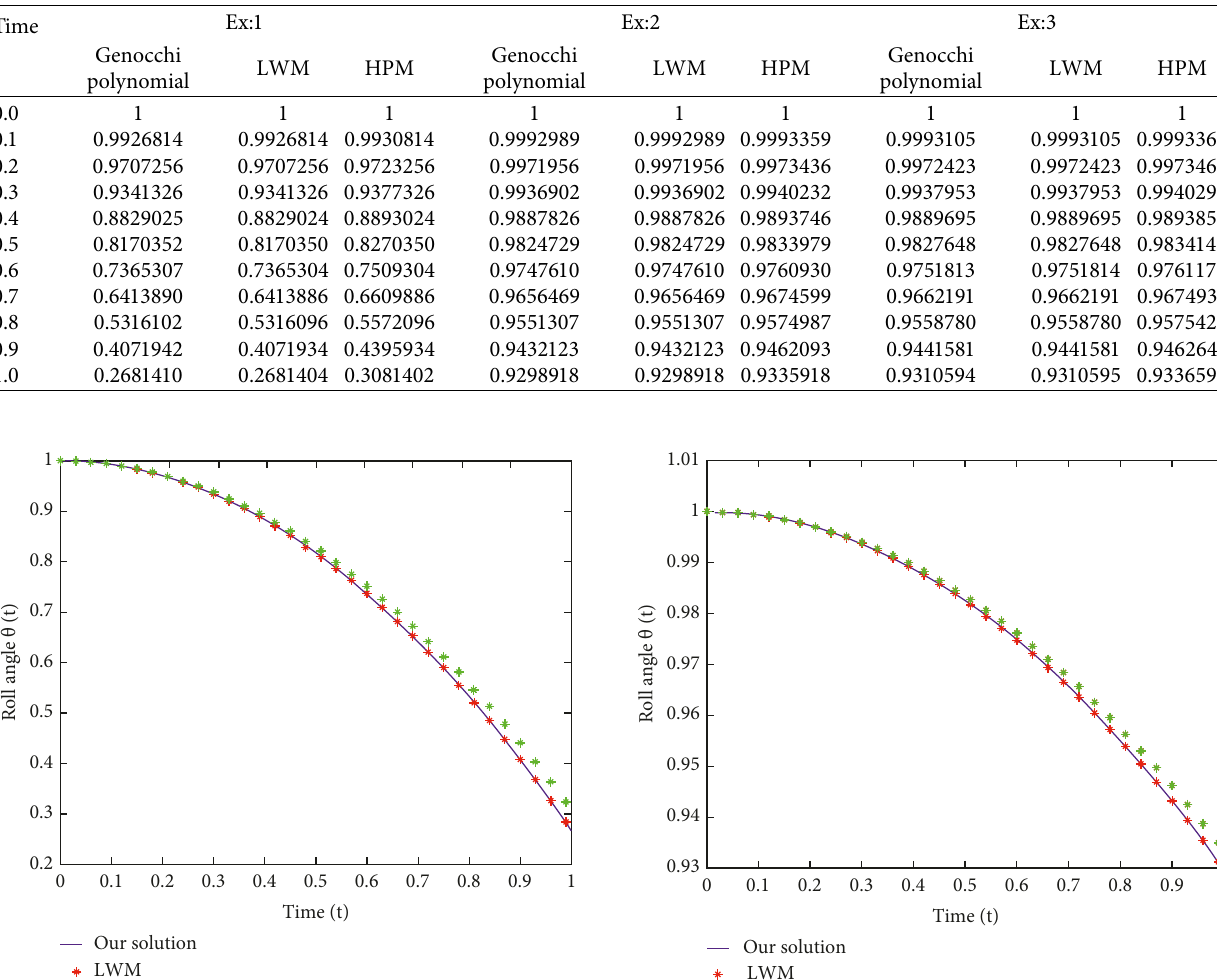
Table 1: Comparative Study of Genocchi polynomial, LWM, and HPM for roll angle with respect to the time t (in sec).